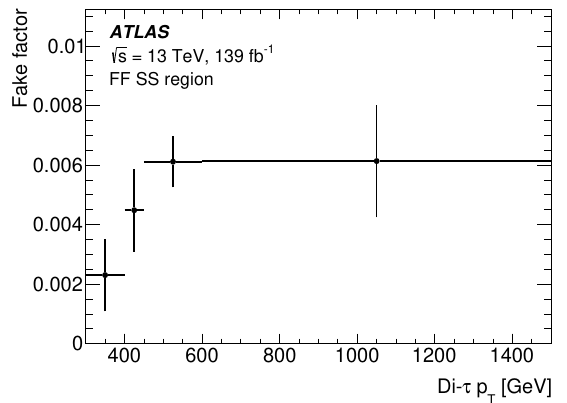
Figure 6. Fake factor as a function of the p T of the di- τ object, computed in the control region labelled as ‘FF SS’ in table 2, with the requirements of Q = +1 for the di- τ object and of zero b -tagged track-jets for the selected large- R jet. The error bars indicate the statistical uncertainties. (instead of pass) the BDT-based identification, but it still fulfils a very loose criterion that corresponds to a cut on the BDT output score with an efficiency above 99%. In fact,